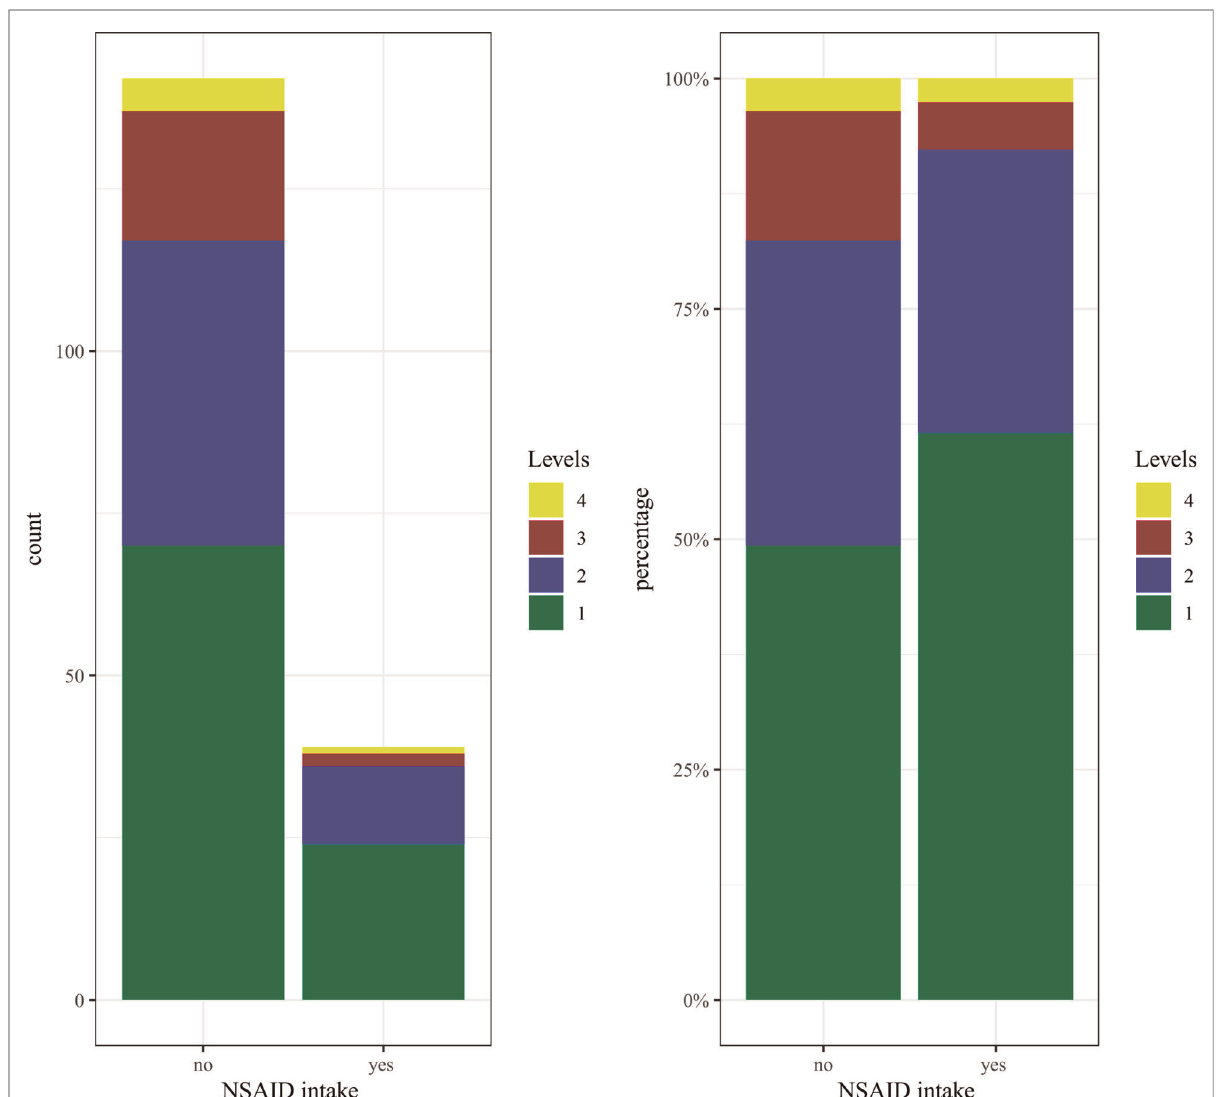
FIGURE 2 Distribution of the number of levels in the NSAID and the non-NSAID group (patients in the NSAID group tend to have fewer segments operated on than patients in the non-NSAID group).